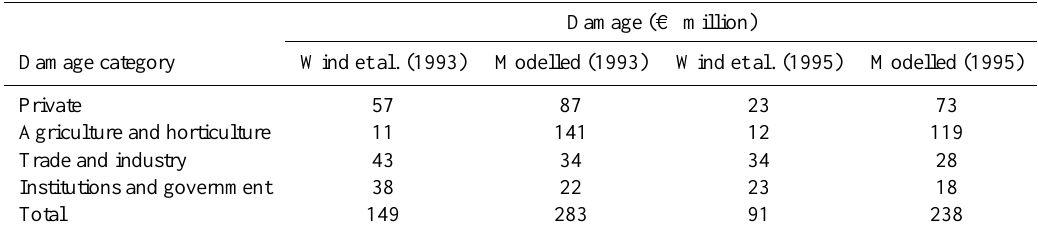
Fig. 6. Frequency distributions (%) of the differences between the inundation depths (in metres) per grid-cell from the inundation maps produced using Floodscanner minus the WAQUA inundation maps for different return periods (RP). Table 3. Estimated damage per land use category for the floods of 1993 and 1995 according to Wind et al. (1999) (updated to year 2000 Eu- ros) and the results of the coupled Floodscanner-Damagescanner model (modelled). Note that the damage categories of the Damagescanner have been reclassed to those reported by Wind et al. (1999) in order to allow comparison. The reclass was carried out as follow (Pri- vate=Residential (high and low density); Agriculture and horticulture=Arable and horticulture, Pasture; Trade and industry=Commercial, Mines/Construction; Institutions and government=Infrastructure, Recreation,